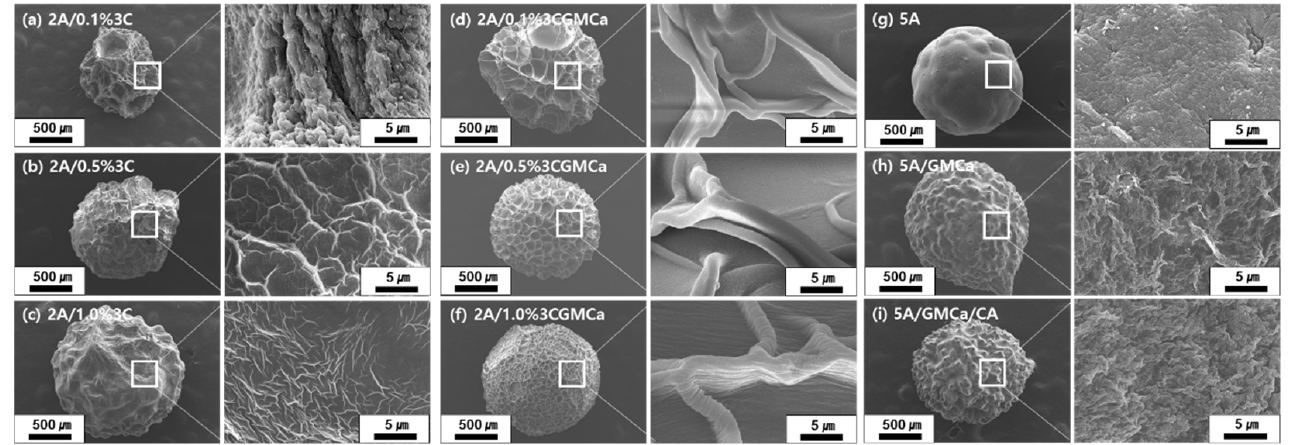
Figure 1. SEM images of alginate-chitosan (2A/x%3C; x = 0.1, 0.5, 1.0) beads with different chitosan content ( a – c ) and gentamicin-loaded alginate-chitosan (2A/x%3CGMCa; x = 0.1, 0.5, 1.0) beads with different chitosan content ( d – f ). Alginate beads: ( g ) alginate-only (5A), ( h ) with gentamicin (5A/GMCa), ( i ) with gentamicin, and then crosslinked with citric acid (5A/GMCa/CA). The right- side images are magnified views of each left-side image.